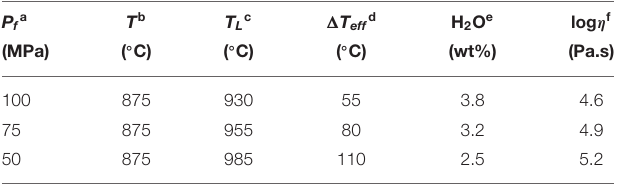
TABLE 1 | Conditions of the decompression-induced crystallization experiments of Mollard et al. (2012).